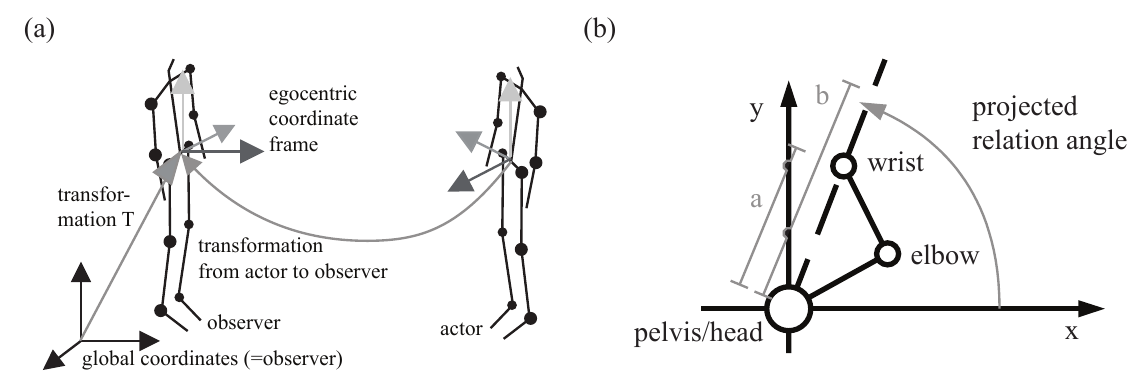
Figure 4. (a) Transformation into egocentric coordinate frame. (b) Illustration of the projected relation angle between wrist and pelvis with respect to the xy -plane. The ratio a / b represents the extension percentage of the arm and is the second used feature.